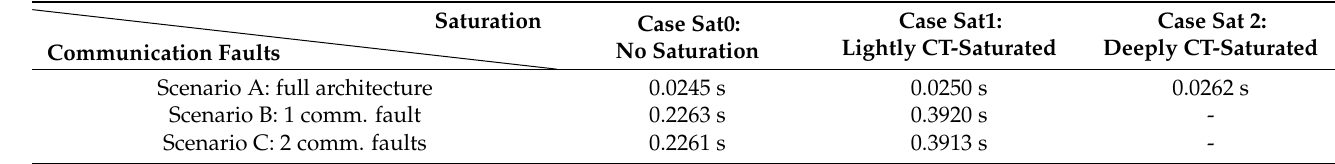
Table 14. Mean trip times obtained for CT saturation tests for line-to-line